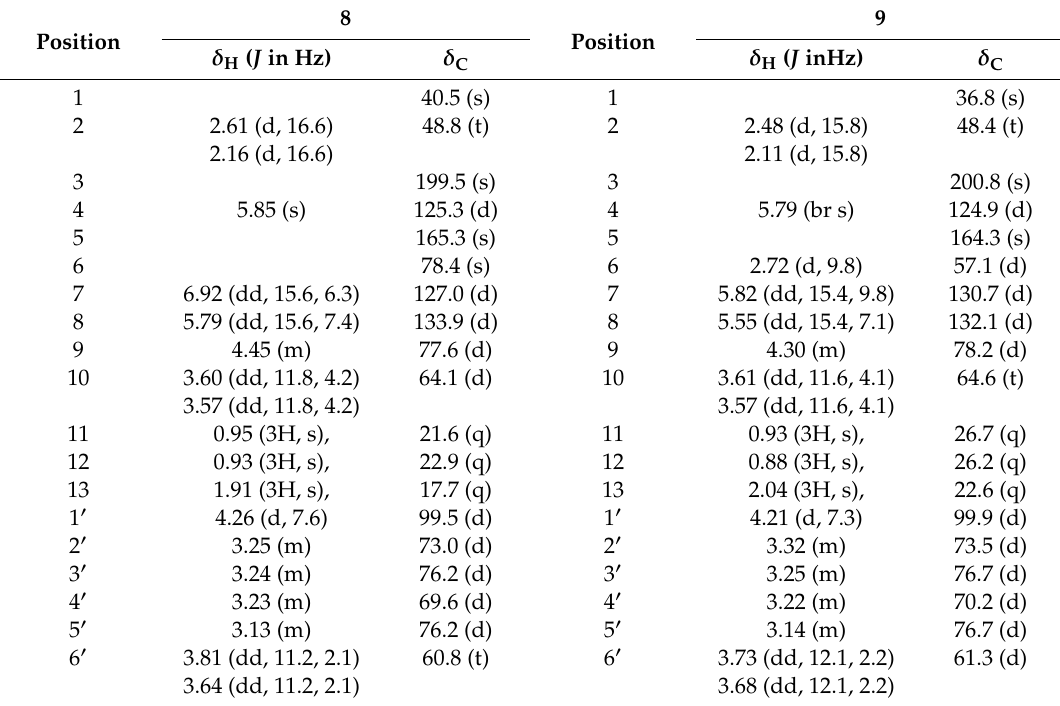
Table 3. 1 H NMR (400 MHz, MeOD) and 13 C NMR (101 MHz, MeOD) spectroscopic data of 8 and 9